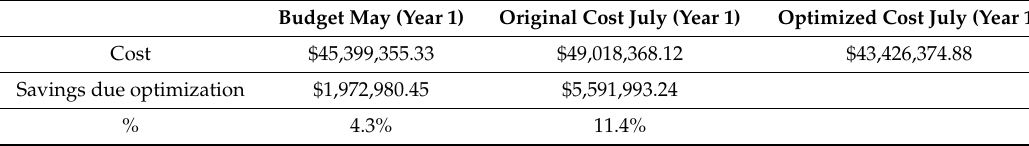
Table 3. Savings due to optimization.